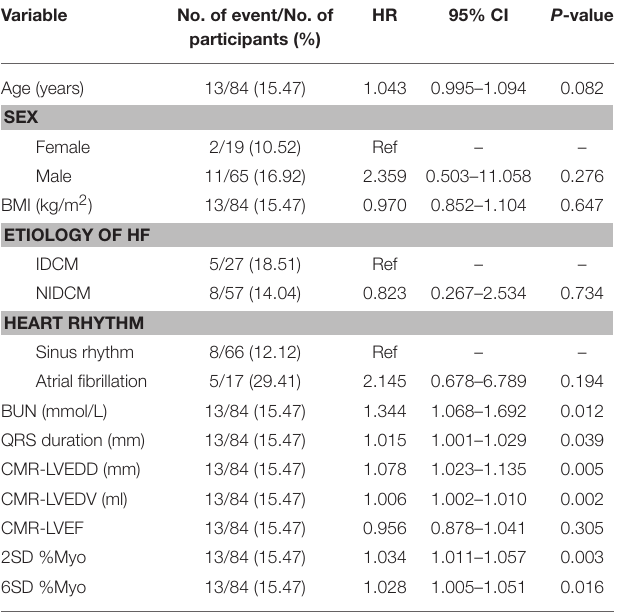
TABLE 2 | Univariate analysis for major adverse events in patients with stage C or stage D heart failure during follow-up. Variable